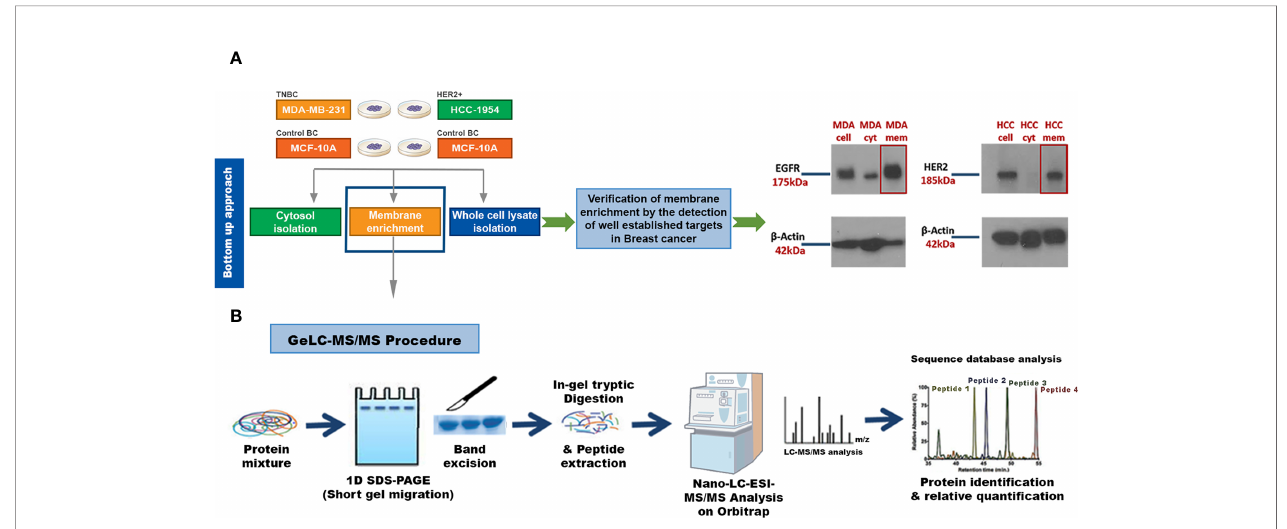
FIGURE 1 | Experimental work fl ow for identi fi cation of candidate Breast Cancer (BC) biomarkers or drug targets using a strategy that combines a membrane enrichment protocol with GeLC-MS/MS technique. (A) Membrane enriched, cytosolic and whole cell lysate fractions from the breast cancerous MDA-MB-231 (MDA) and HCC-1954 (HCC) cell lines were isolated and analyzed by Western blot, using well established BC membrane targets (HER2 and EGFR), to verify the success of the membrane enrichment. (B) Membrane enriched fractions were then subjected to 1D SDS-PAGE gel electrophoresis, in-gel trypsin digestion, and tandem mass spectrometric analysis on a high resolution Orbitrap. Protein identi fi cation and quanti fi cation was performed using bioinformatic tools (Sequest database search). Cell, whole cell lysate fraction; cyt, cytosolic fraction; mem, membrane